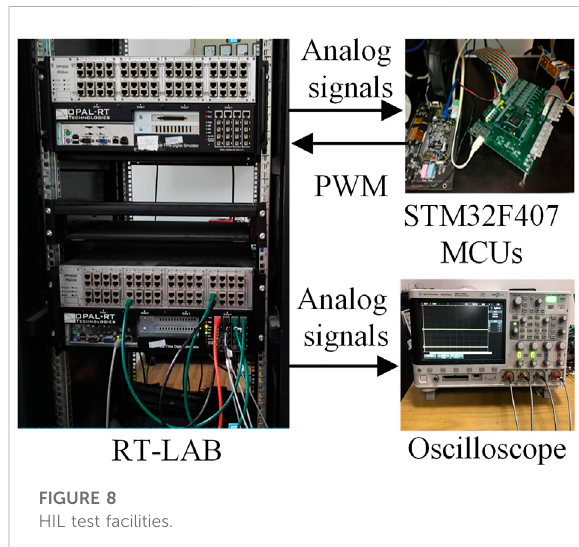
FIGURE 8 HIL test